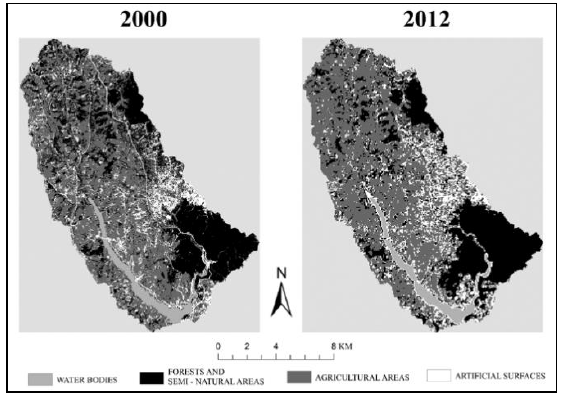
Figure 4. Classification results